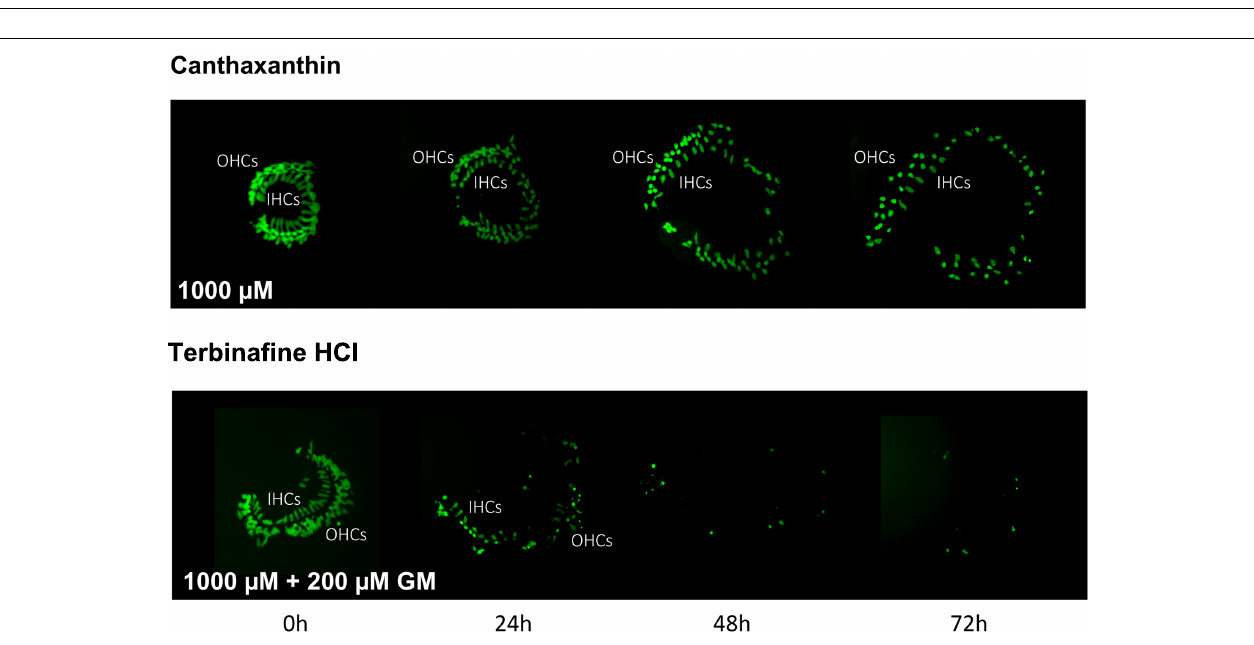
FIGURE 3 | Normalized D1-4 HC survival curves for two antioxidants (canthatraxin and terbinafine HCl) that had no significant effect on normal or gentamicin-treated micro-explants. HC survival with 1000 µ M of the compound alone (open green circles) was not significantly different from an untreated, negative control micro-explant (open black circles). Treatment with the compound at 10 µ M (solid red circles), 100 µ M (solid blue) or 1000 µ M (solid green) plus 200 µ M gentamicin was not significantly different from 200 µ M gentamicin alone (solid black). N = 6 micro-explants per data point.